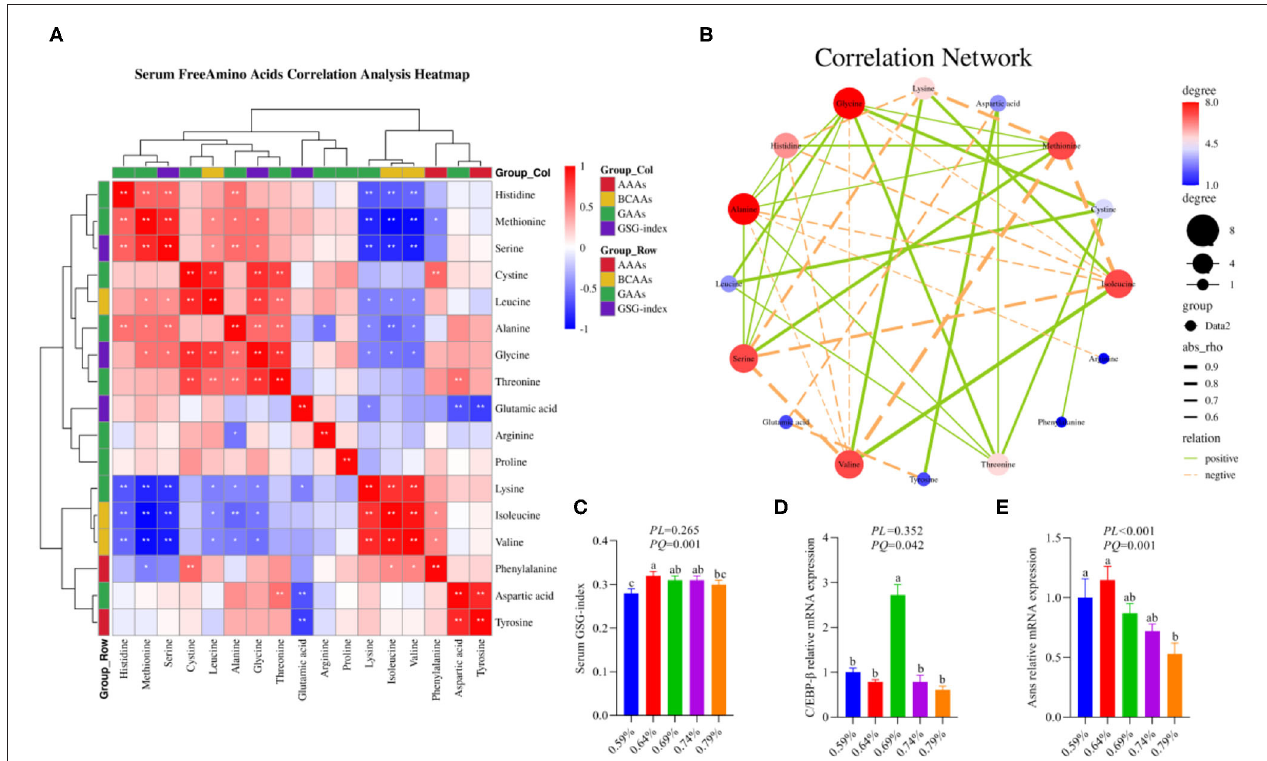
FIGURE 1 | Dietary valine changed serum free amino acid profile and liver amino acid metabolism ( n = 6–8). (A) Serum-free amino acids correlation analysis heatmap. (B) Correlation network. (C) Serum GSG-index. (D) C/EBP- β relative mRNA expression level. (E) Asns relative mRNA expression level. * P < 0.05 and ** P < 0.01. a − c Means with different superscripts within a column differ significantly ( P < 0.05). GSG index, Glutamate–serine–glycine (GSG) index [glutamate/(serine1glycine)]; AAAs, aromatic amino acids; BCAAs, branched-chain amino acids; GAAs, glycogenous amino